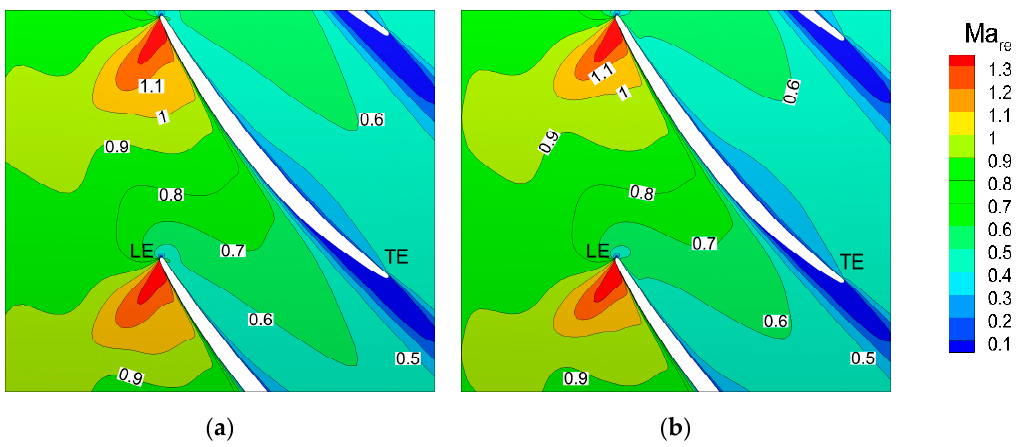
Figure 15. Relative Mach number in 70% of the span height of second-stage rotor of the original and optimized compressor. ( a ) Relative Mach number of the original compressor; ( b ) relative Mach number of the optimized compressor.